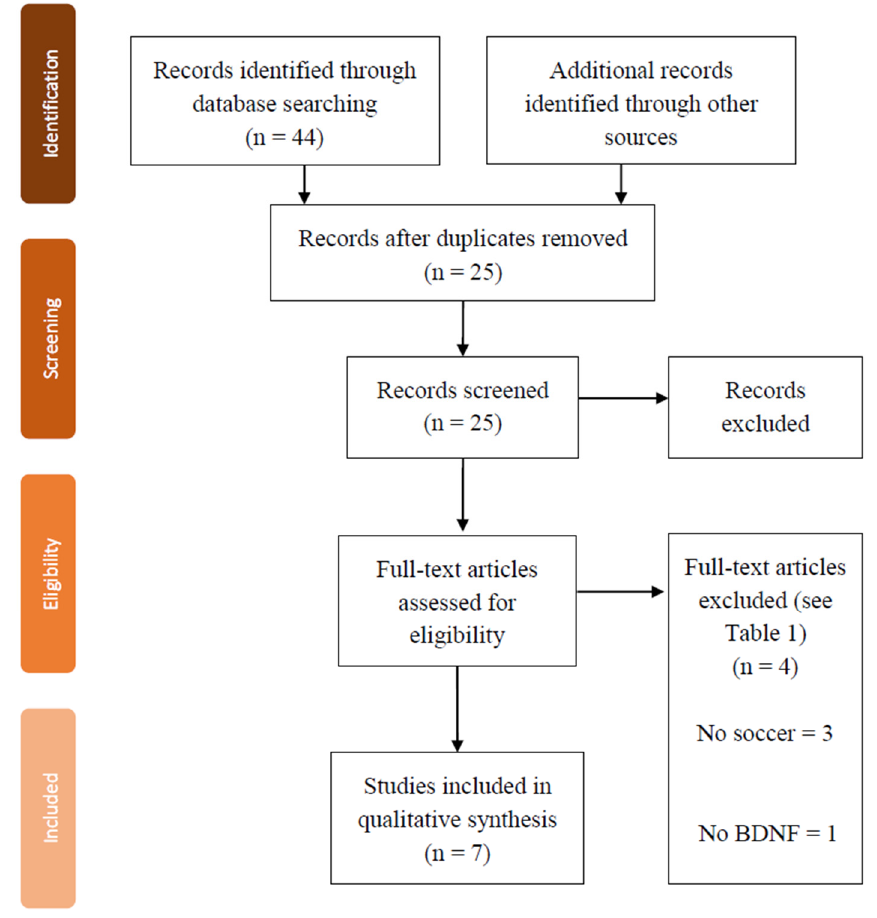
Figure 1. Flow diagram of the study, see Table 1. Table 1. Inclusion and exclusion